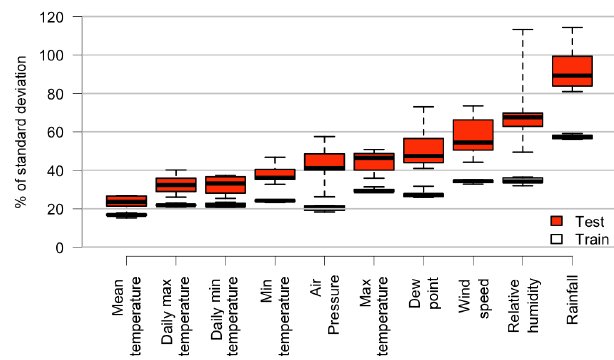
Figure 4. Relative magnitude of training and testing dataset errors, from 10 validation rounds of climate variable modeling. A value of 100 indicates, for that climate model, that the average difference between the value recorded at a given weather station and the value predicted by the model at that location is equal to the standard de- viation of the initial set of all values recorded at all weather stations for that climate variable.